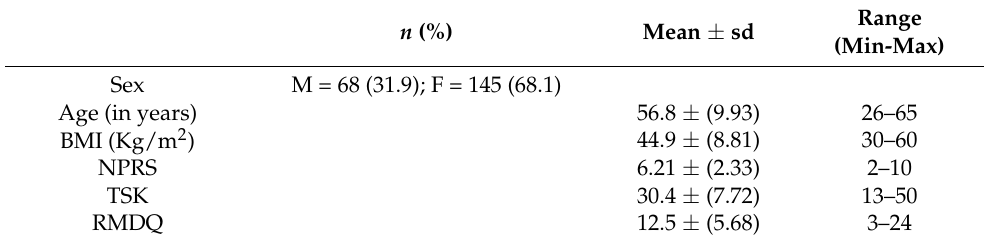
Table 1. Demographic and clinical characteristics of the sample ( n =